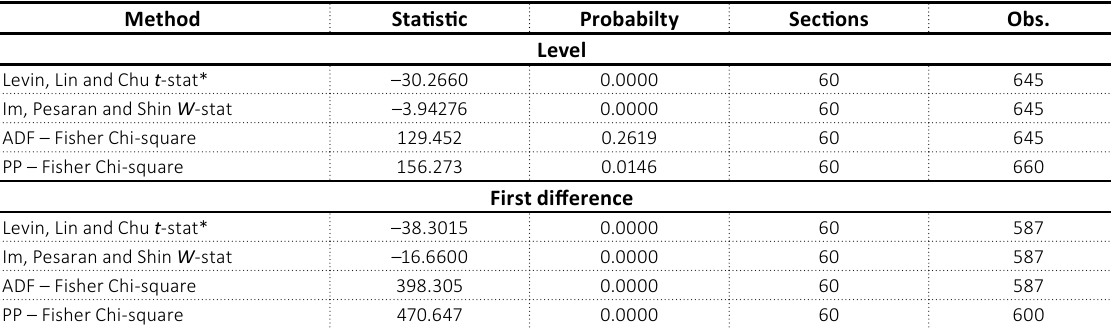
Table 2. Results: panel unit root